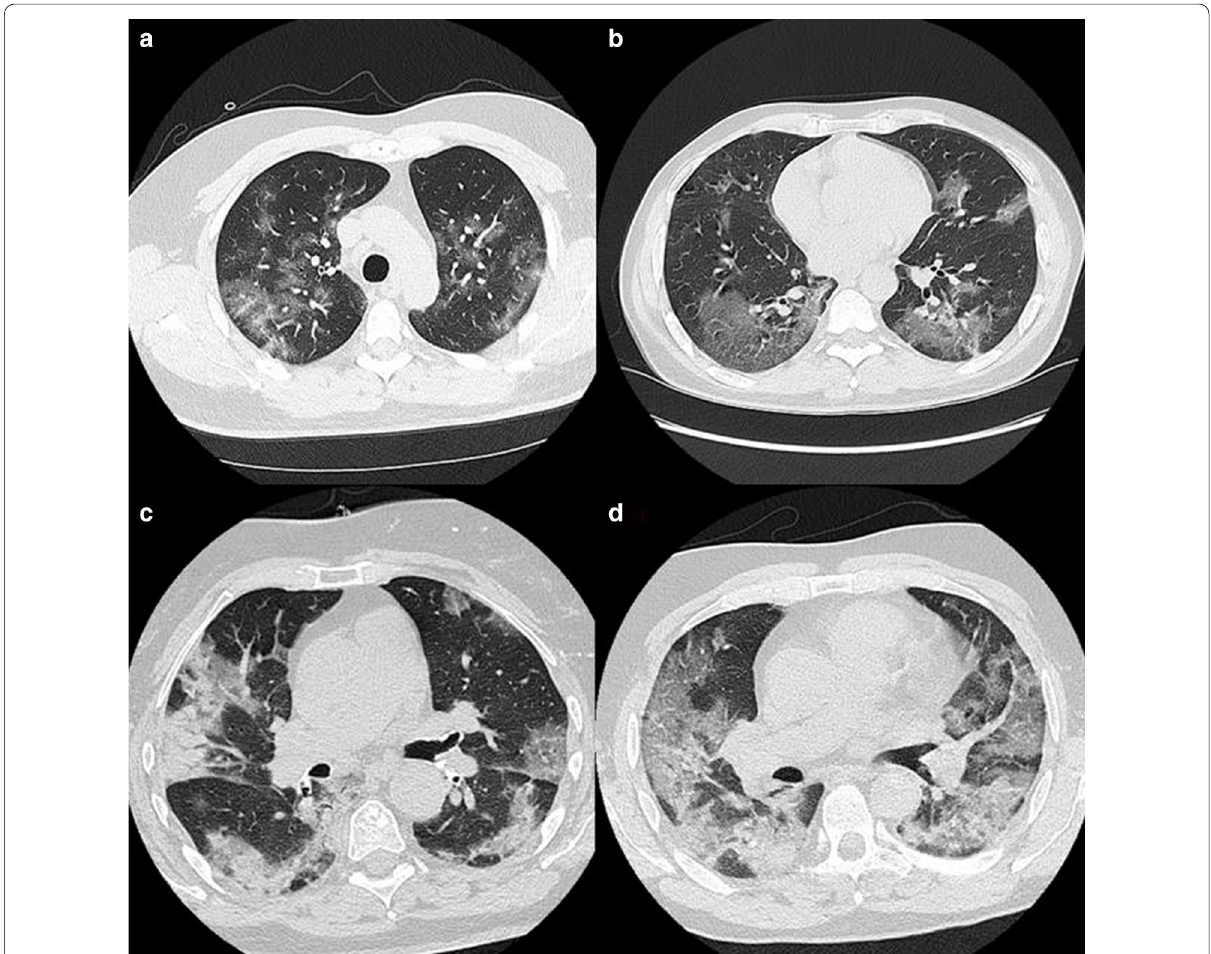
Fig. 1 Axial thin-section CT scans in four COVID-19 patients with negative RT-PCR at baseline. a 15-year-old male (6 days after symptom onset to CT scan) shows multiple focal ground-glass opacities associated with linear inter and intralobular septal thickening in upper lobes. b 54 years old male (10 days after symptom onset to CT scan) shows bilateral and predominantly peripheral consolidation pattern in both lower lobes. c 73 years old female (7 days after symptom onset to CT scan) shows extensive bilateral, peripheral, sub-pleural mixed ground-glass opacities in both lower and upper lobes. d 56-year-old male (10 days after symptom onset to CT scan) shows predominantly diffuse consolidation in both